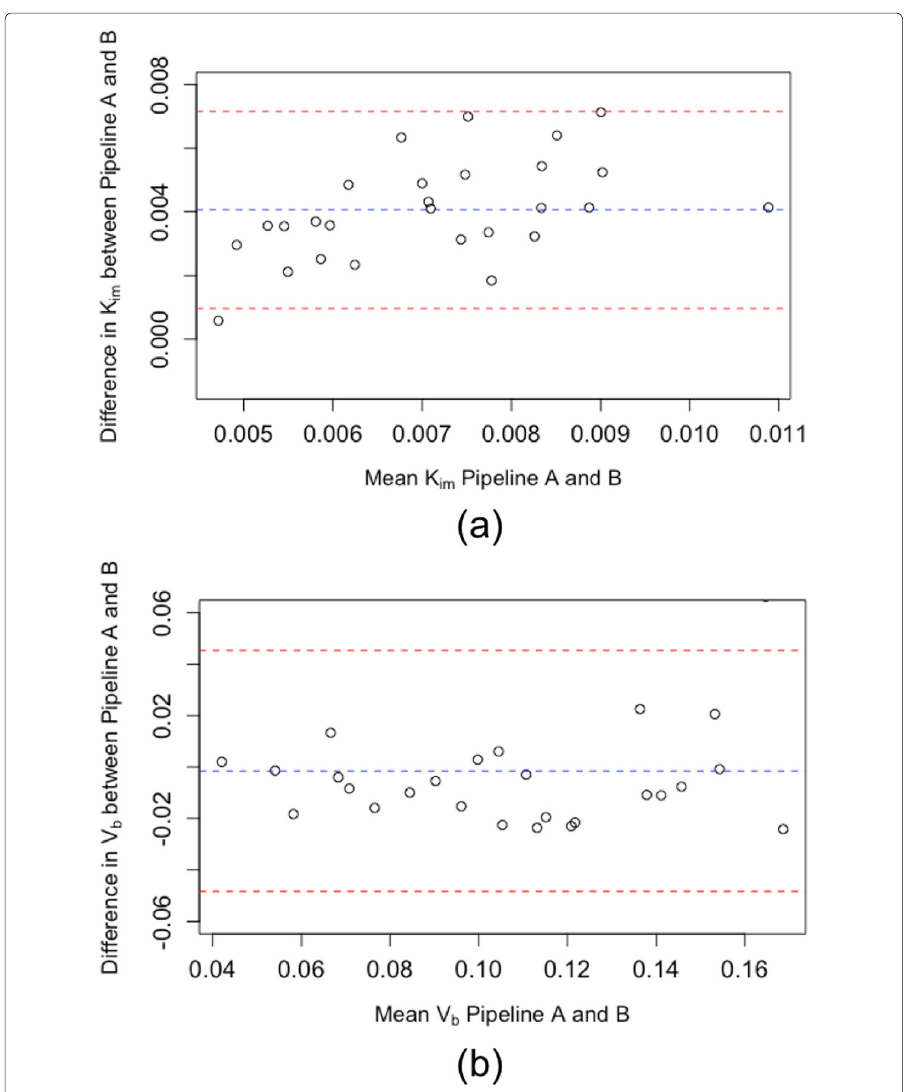
Fig. 4 Bland-Altman plots comparing outcome parameters of a pulmonary compartmental model of 18 F-FDG. ( a ) K im -the metabolic rate constant of FDG. ( b ) V b -the fractional blood volume. These are the initial results using two different analysis pipelines. Adjustment of pipeline B led to improved agreement between the pipelines (see Fig.